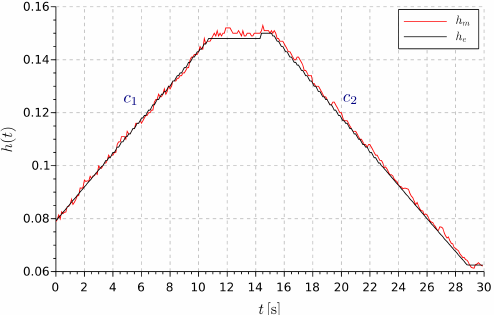
Figure 9. Estimation of correction coefficients on the filling of the tank, when ˜ q in (cid:54) = 0 and q out = 0 (marked by c 1 ) and emptying, when ˜ q in = 0 and q out (cid:54) = 0 (marked by c 2 ); h m —measured level, h e —numerically estimated level.